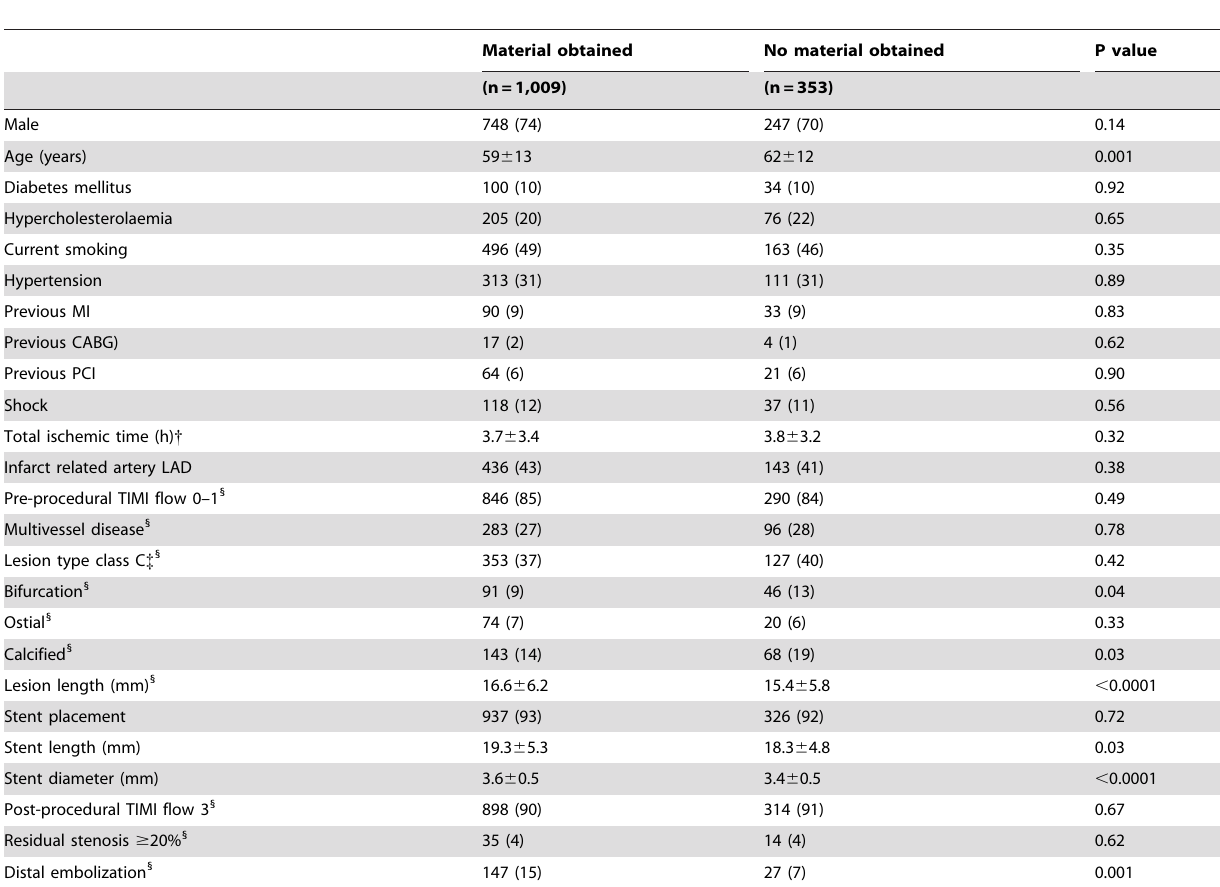
Table 1. Clinical, angiographic and procedural characteristics of the 1,362 patients treated with thrombus aspiration during primary